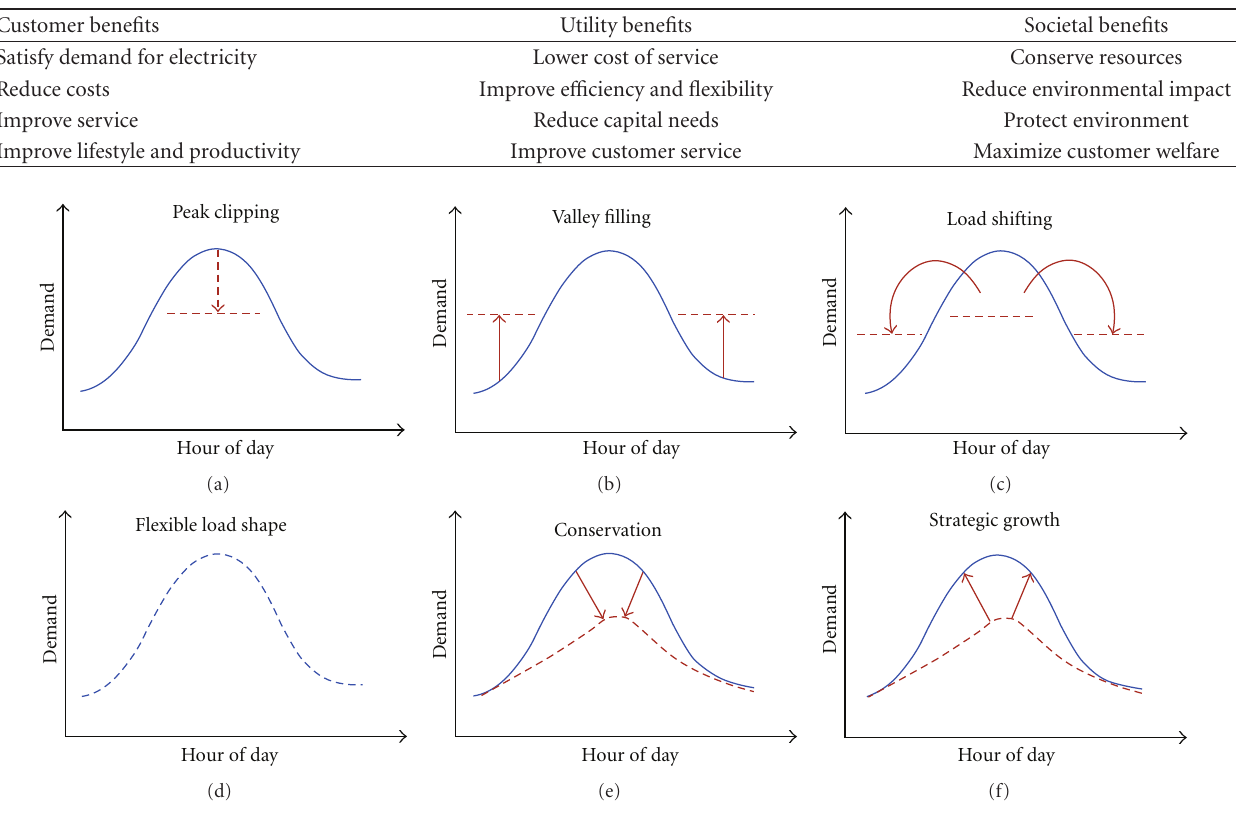
Figure 2: DSM-load shape objectives.